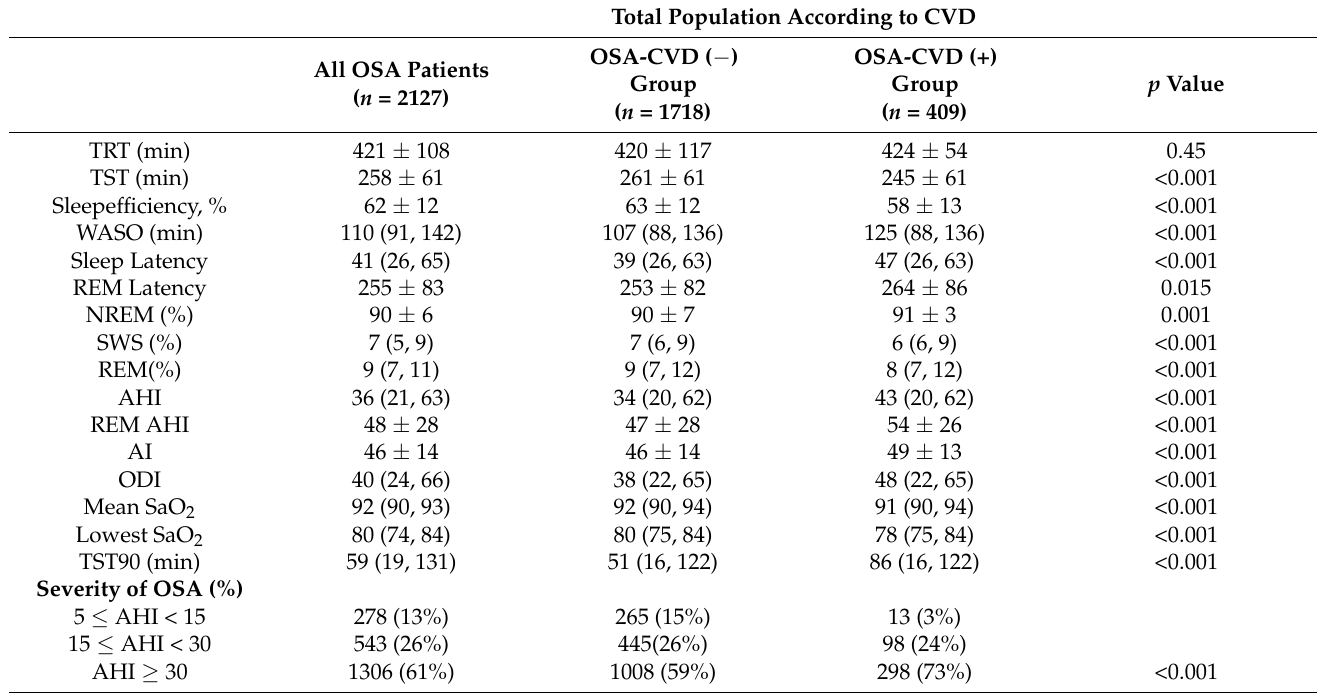
Table 2. Polysomnography characteristics of the study population.